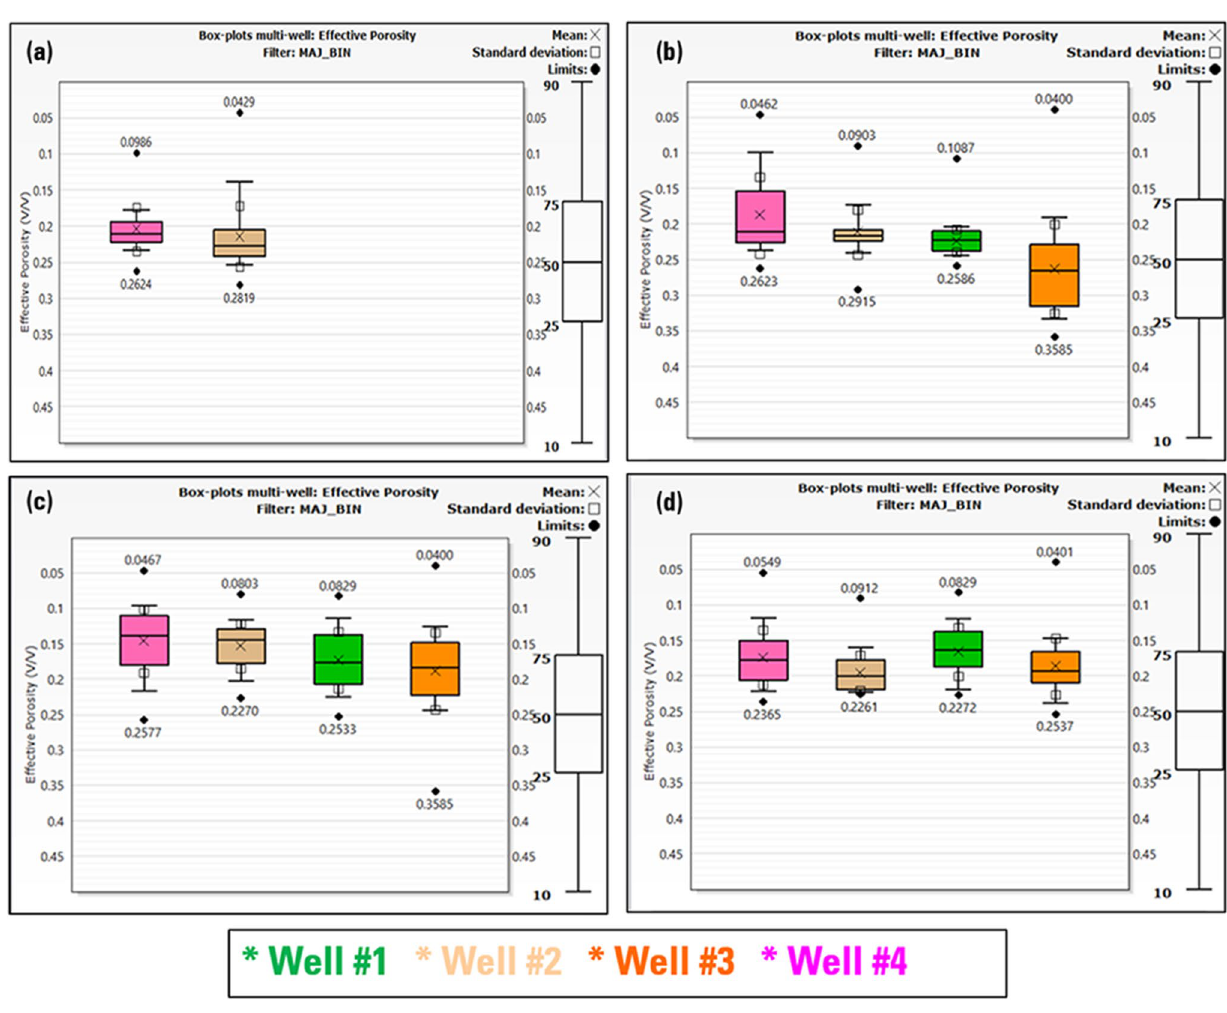
Fig. 6 Facies Codes frequencies in all Formations and for all studied wells. a Facies Code 1—Orange one in FMI, b Facies Code 2—Green one in FMI, c Facies Code 3—Light Blue in FMI and d Facies Code 4—Dark Blue in